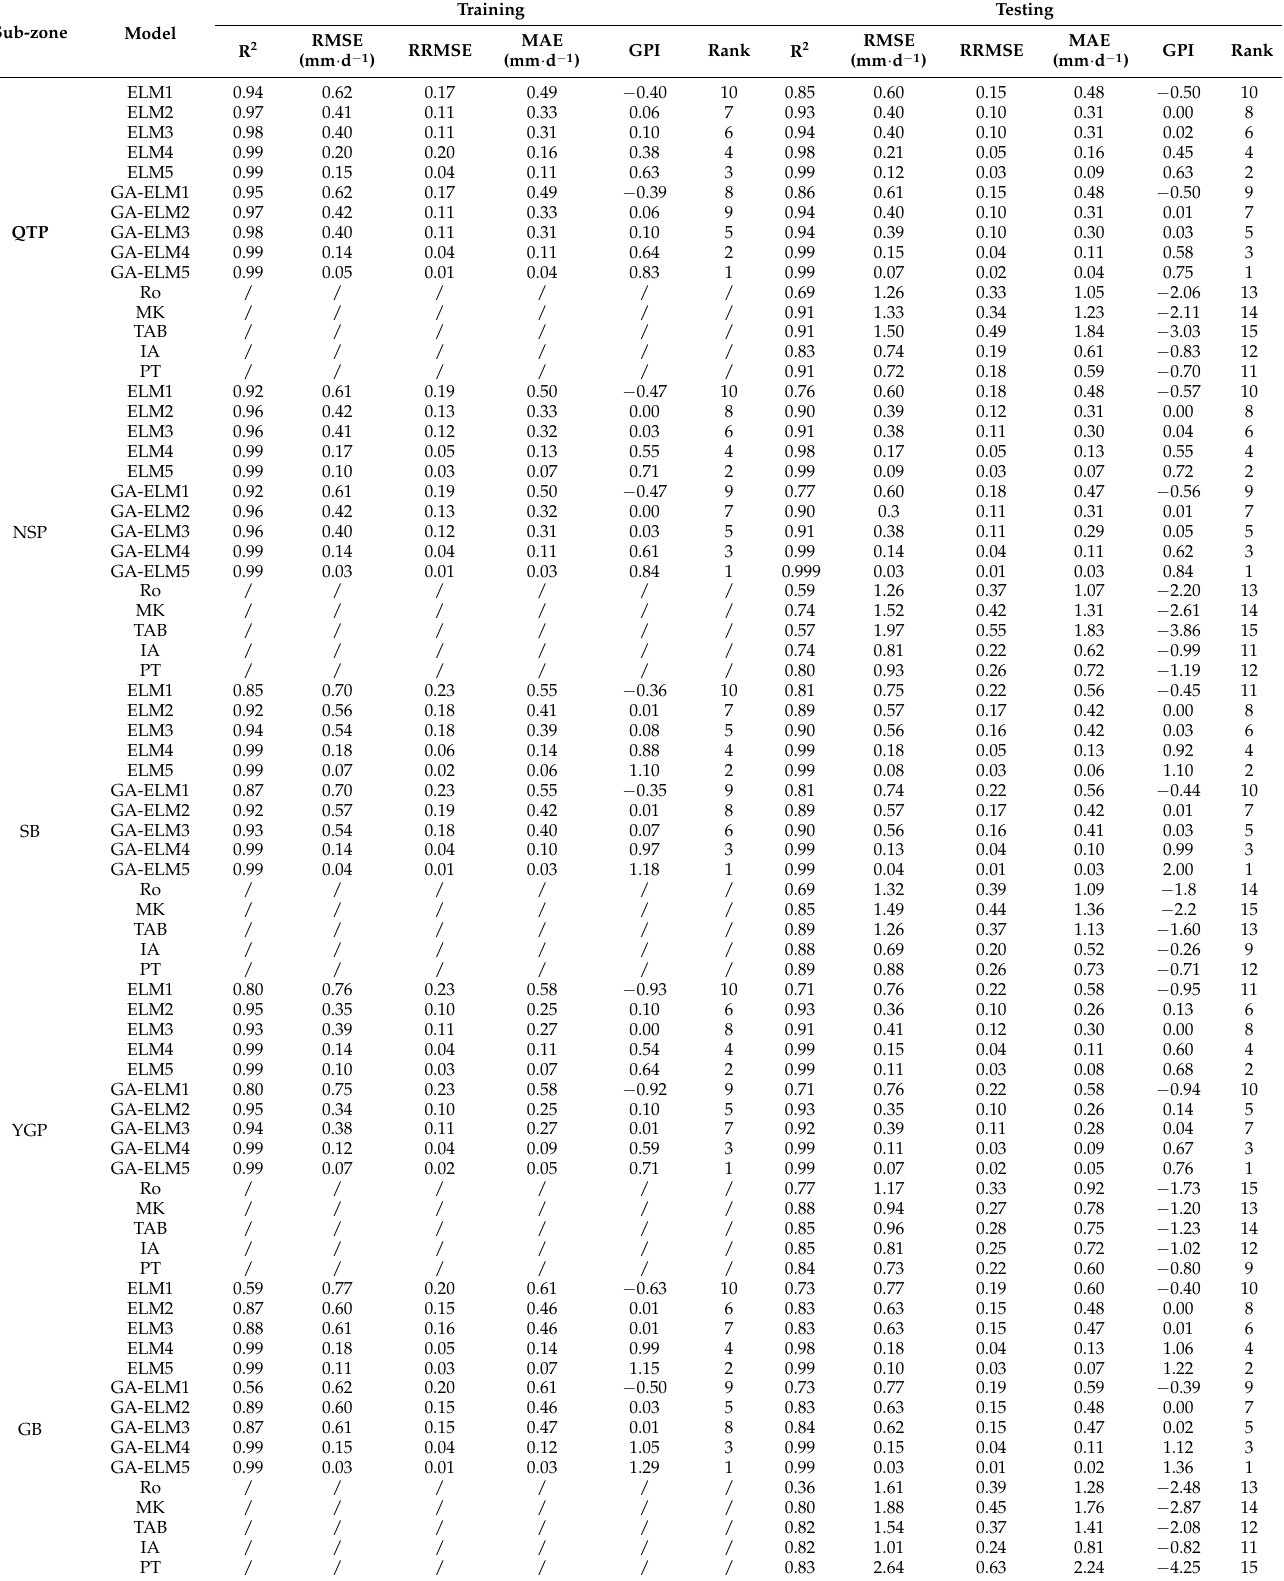
Table 3. Statistical performance of ET 0 models in